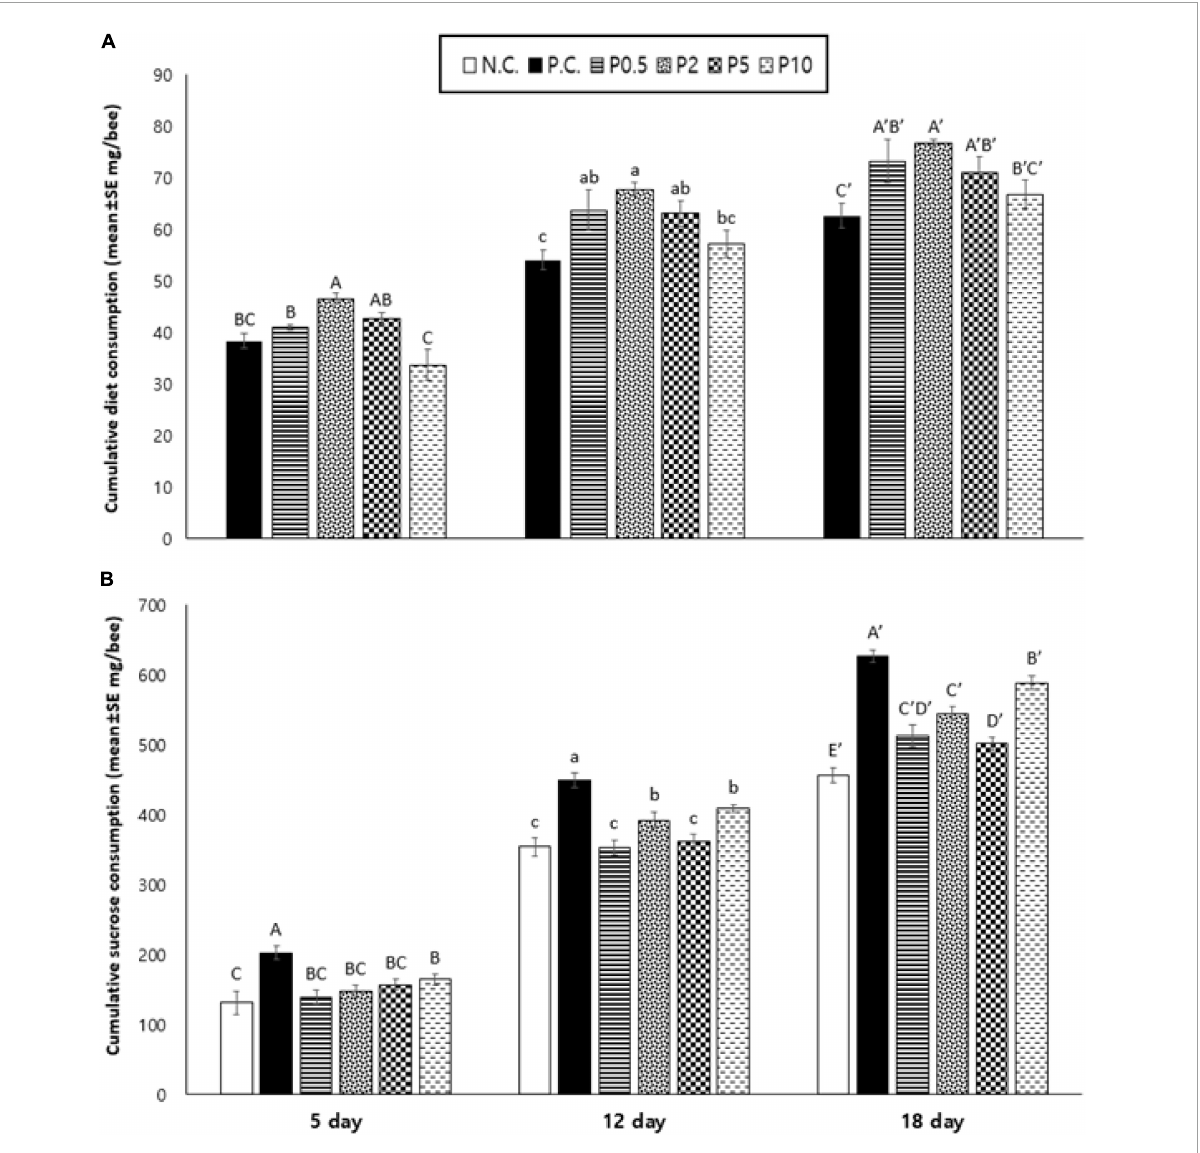
FIGURE3 Cumulative consumption of (A) diet and (B) sucrose content (mean ± SE mg/bee) measured on days 5, 12, and 18 in caged honey bees fed with different diets. NC means negative control; PC means positive control. Different letters over the bar indicate statistically significant differences ( p <